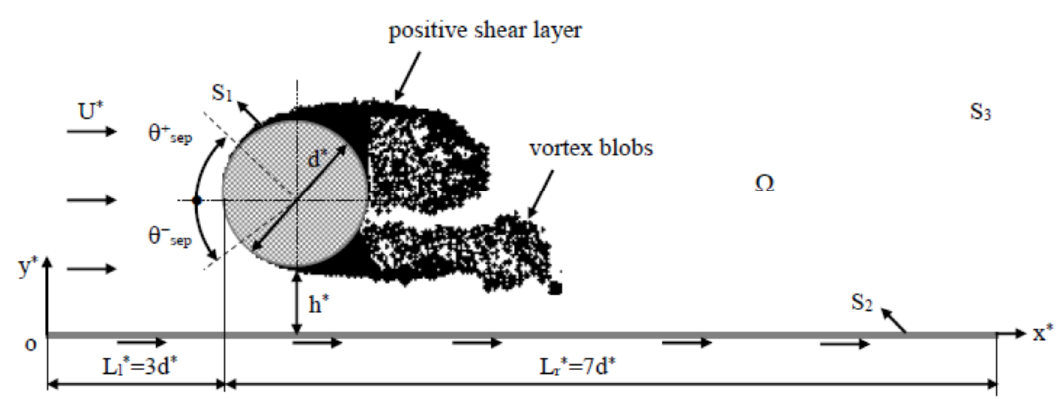
Figure 1. Schematic representation of the semi-infinity fluid domain.